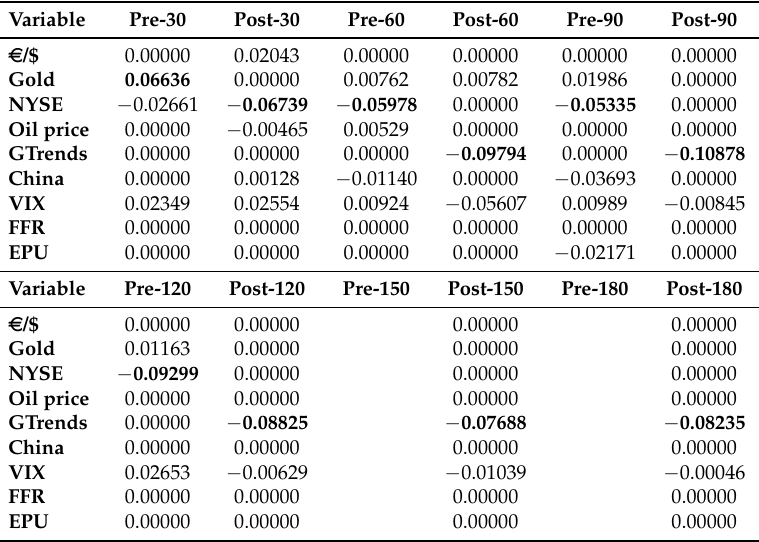
Table A3. PC-LASSO coefficients for Bitcoin cash.